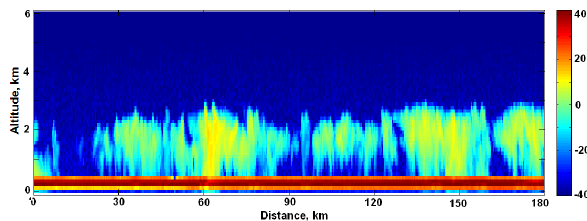
Figure 5: Image of co-polarization radar reflectivity factor obtained by the ACR. The high values (>30 dBZ) near the surface correspond to the sea surface returns. Below the sea surface, no radar return is allowed. However, multiple scattering of microwave between clouds and the sea surface makes some of the radar returns appear to be from below the sea surface.